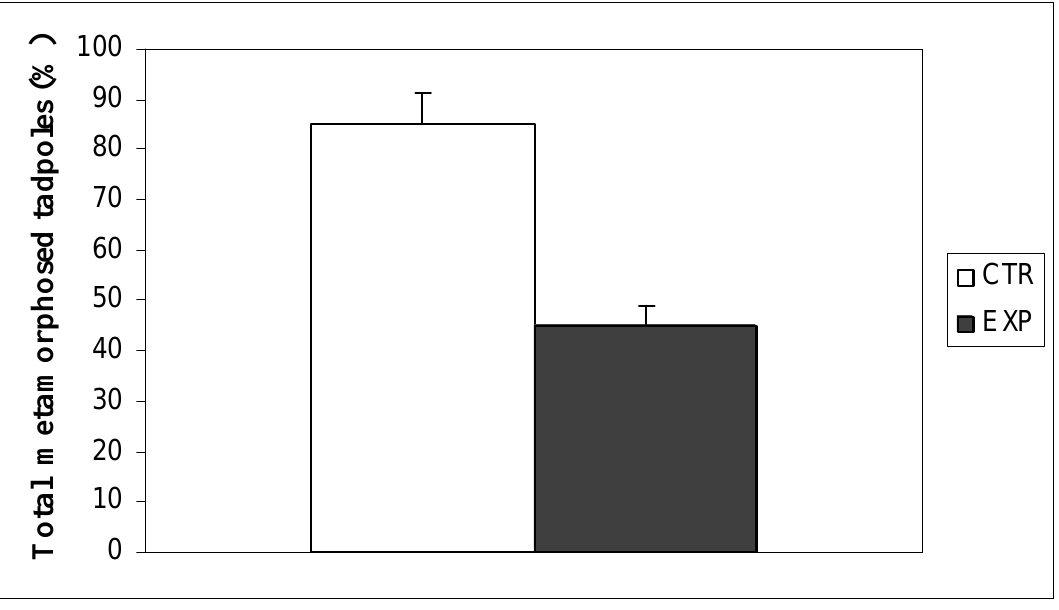
FIGURE 3 . MF dependence of complete metamorphosis in the total tadpole population. The columns show the percentage of individuals that completed their metamorphosis during the experimental time. (1) Unirradiated (control) tadpoles; (2) irradiated tadpoles. The data represent the mean of four sets of